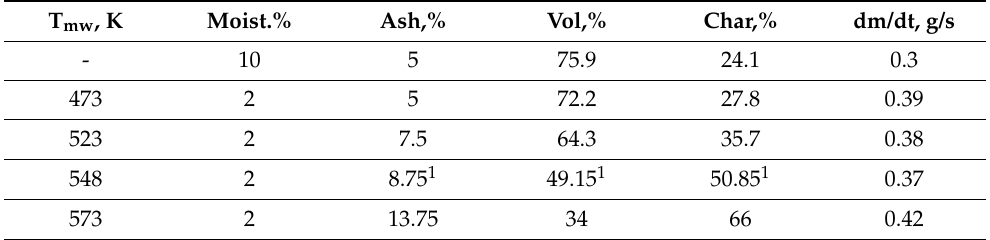
Table 1. Proximate analysis of straw biomass pellets and estimated steady state mass loss rate. T mw , K